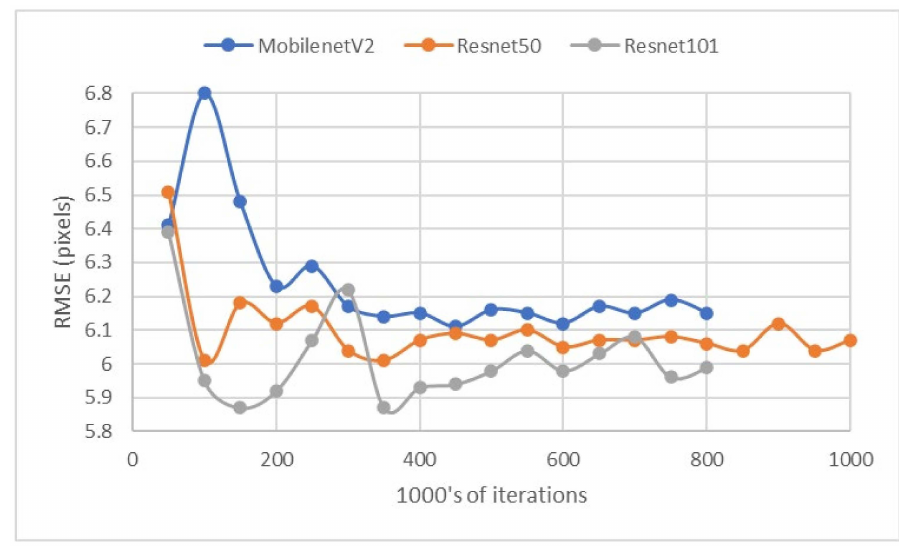
Figure A2. RMSE for ultrasound test set (excludes points with confidence less than